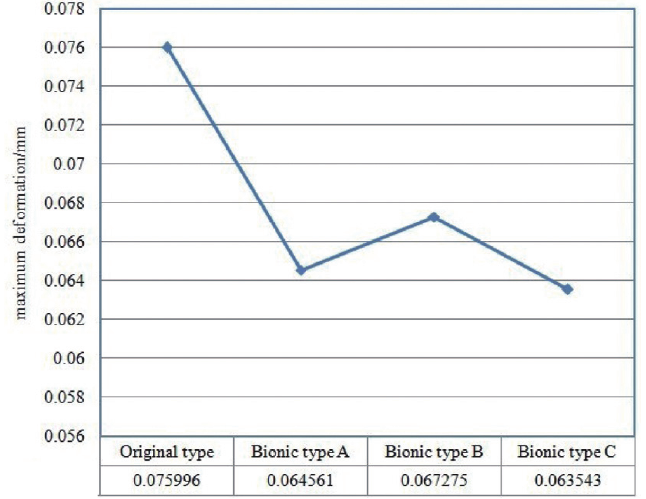
Fig. 11. The maximum deformation graph.